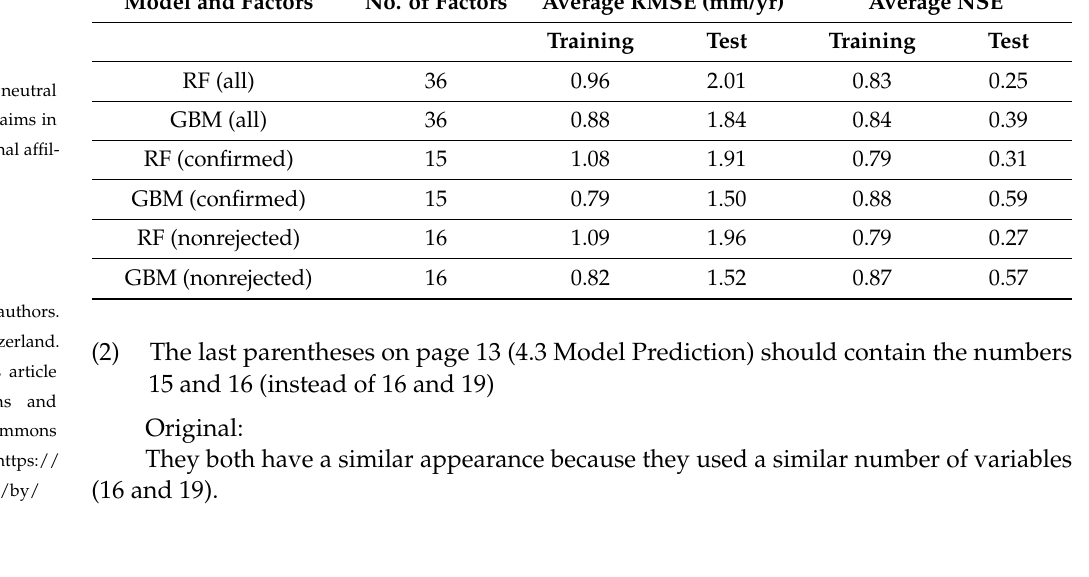
Table 3. Performance comparison of machine learning models using threefold cross-validation. Model and